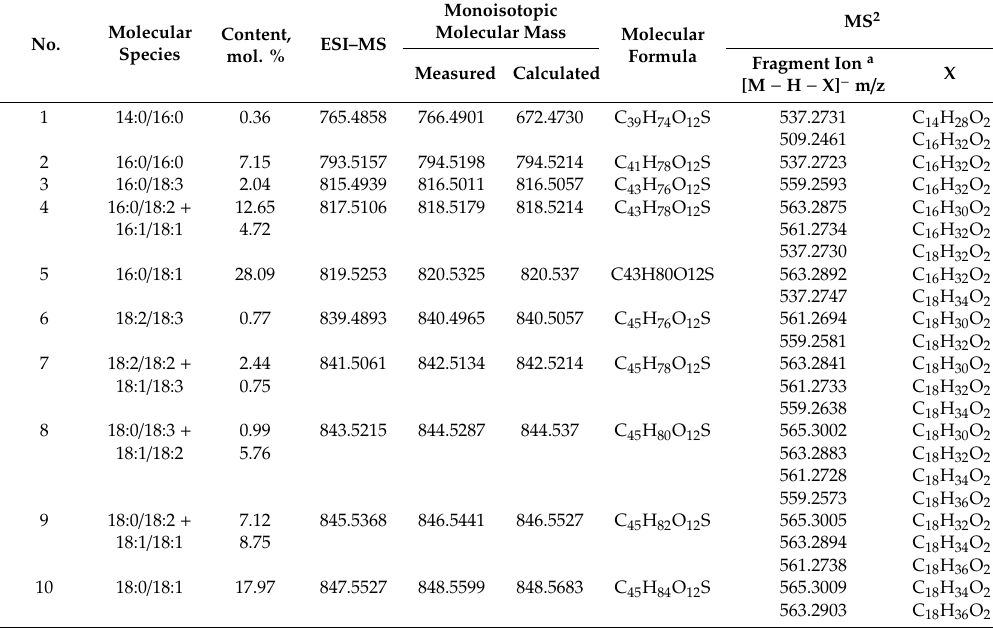
Table 9. Molecular species of sulfoquinovosyldiacylglycerol (SQDG) from Madhuca ellitica seeds. Monoisotopic Molecular Molecular Mass Molecular Content, No. ESI–MS Species mol. % Measured Calculated Fragment Ion